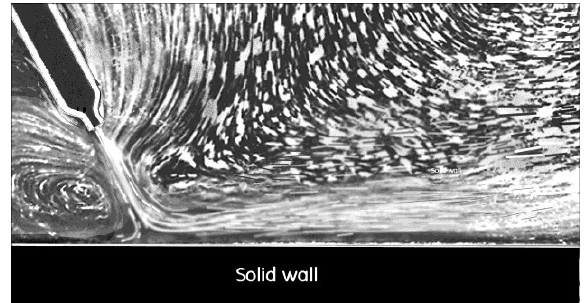
Fig. 3. Two-dimensional jet impact flow visualised by tiny particles in water. The jet issuing from the nozzle at left forms a wall-jet exhibiting no tendency to flow “reflection” or “bouncing”. What may look like a small lifting effect at right is wall-jet thickness growth, which cannot generate any useful lift force on tra transported